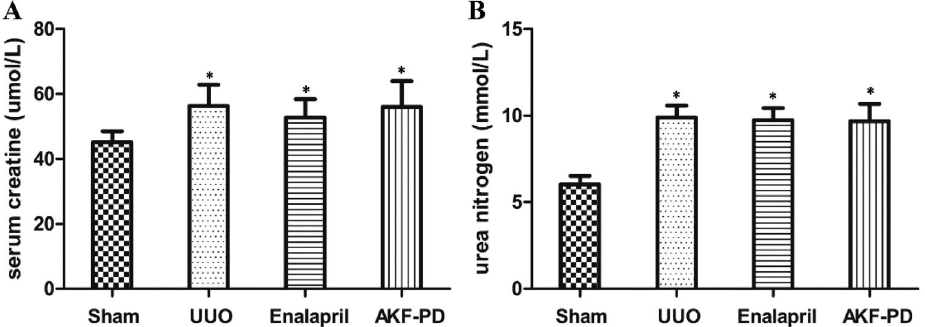
Figure 1. Fluorofenidone (AKF-PD) had no effect on renal function in the unilateral urinary obstruction (UUO) group. A , Semiquantitative analysis results of serum creatine and ( B ) urea nitrogen in the sham, UUO, UUO + enalapril, and UUO + AKF-PD groups. Data are reported as means ± SD. *P o 0.05 vs the sham group